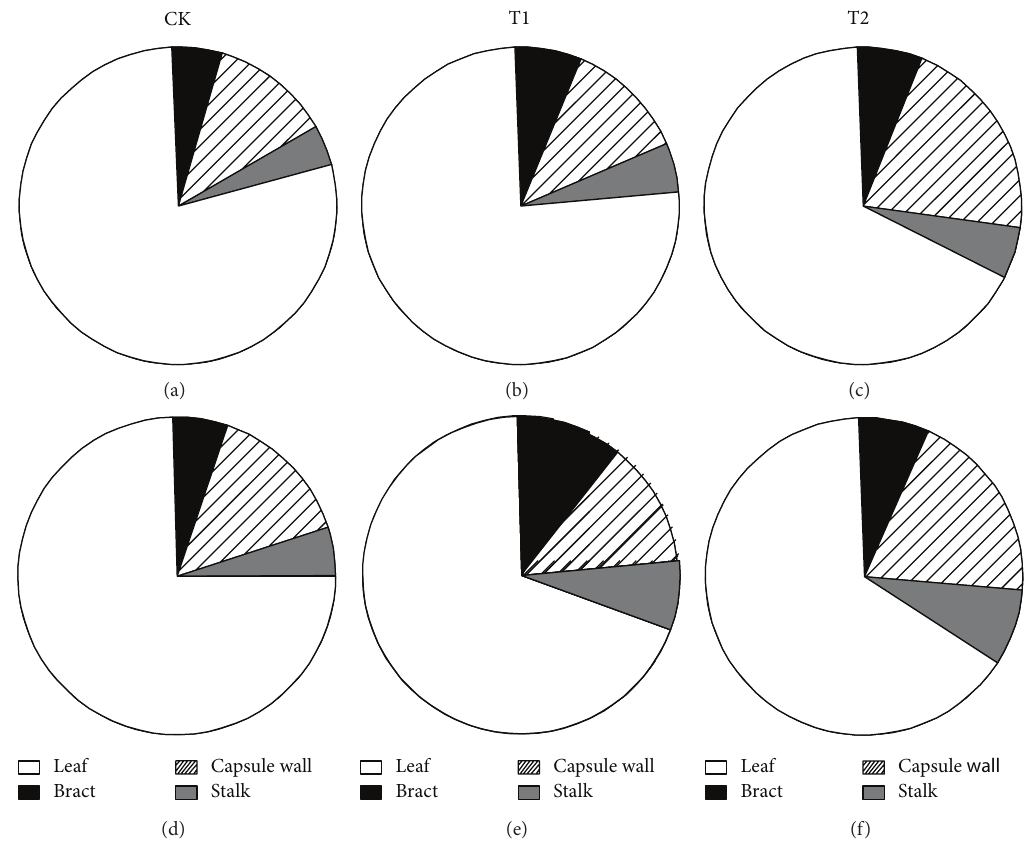
Figure 4: Relative contribution (%) of each plant organ to canopy apparent photosynthesis of Xinluzao 45 ((a)–(c)) and Xinluzao 33 ((d)–(f)) at the full boll stage. CK: conventional irrigation; T1: slight deficit irrigation; T2: moderate deficit irrigation. The contribution of fallen leaves or other plant parts was not taken into